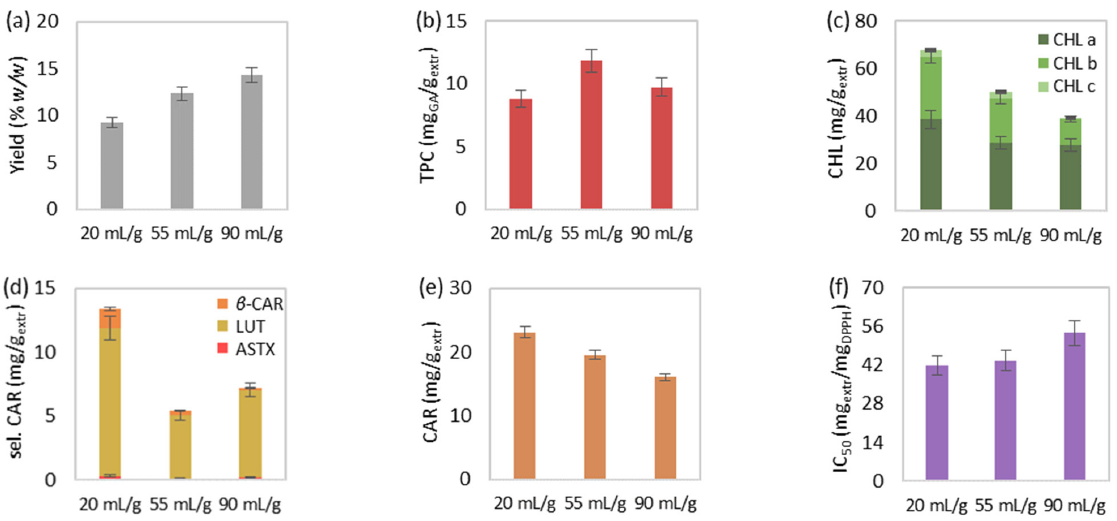
Figure 2. The effect of solvent-to-biomass ratio on MAE’s ( a ) extraction yield, extract’s total ( b ) phenolic and ( c ) chlorophyll content, ( d ) select and ( e ) total carotenoid content, and ( f ) antioxidant activity. The extraction conditions of the single-factor experiments were maintained at 50 ◦ C, 15 min and 550 watts.